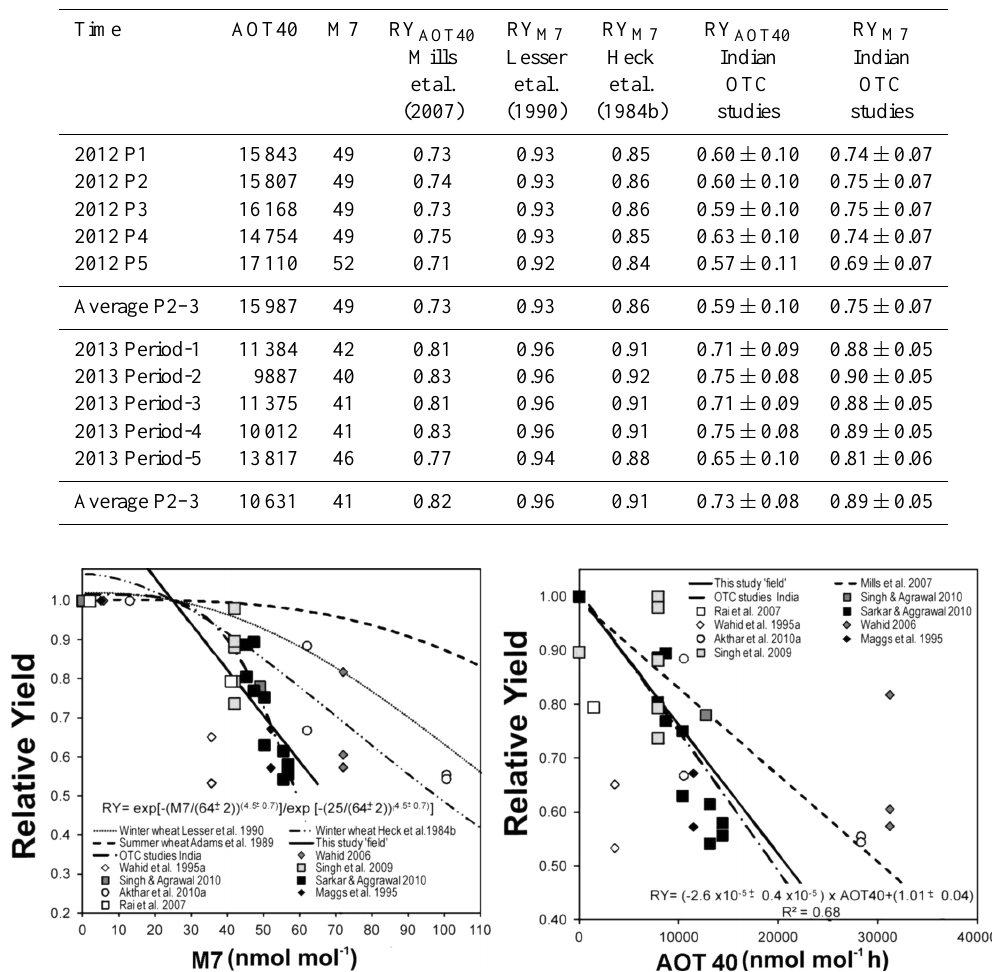
Table 6. Ozone exposure according to different exposure indices and relative yields for wheat. Data for the five periods used to plot Fig. 5 are provided in the table. Period 2 (P2) and Period 3 (P3) correspond to the periods in which wheat is usually grown in Punjab and Haryana in the rice–wheat cropping cycle, while Period 4 (P4) and 5 (P5) correspond to the cotton–wheat cropping cycle. The average yield loss of the rice–wheat cycle is used to calculate crop production loss and economic loss for each fiscal year as most of the area is cultivated in the rice–wheat cropping system.